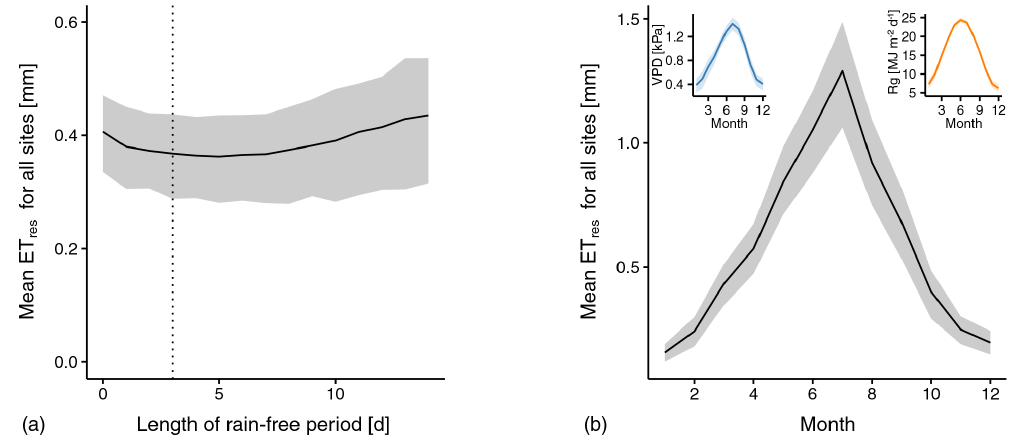
Figure 3. Sensitivity of ET res to varying length of filtering after precipitation events (a) . The dotted, vertical line indicates the 3-day period we adopted from Beer et al. (2009) monthly estimation of the intercept parameter ET res . The inset plots illustrate the mean seasonal variability in VPD and Rg for all sites on a monthly scale (b) . In all plots, the solid line is the mean for all sites; the band denotes the 95% confidence interval of the mean derived by bootstrapping. Table 2. Mean MEF diff comparison for different model variants. Entries indicate the mean of the difference MEF(row model)–MEF(column model) for all 110 sites. Zhou + ETres + VPD + Rg